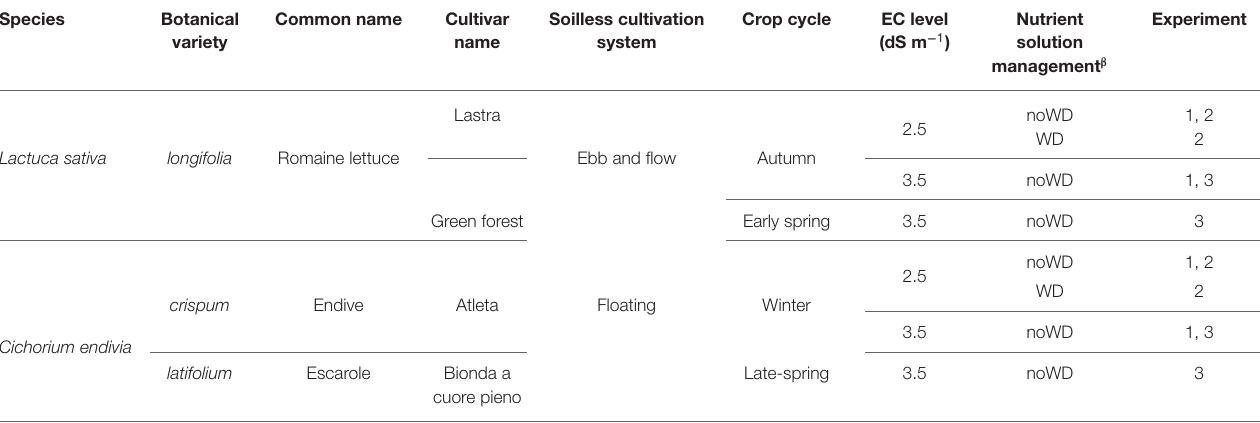
TABLE 1 | Treatment details for the different experiments. Species Botanical